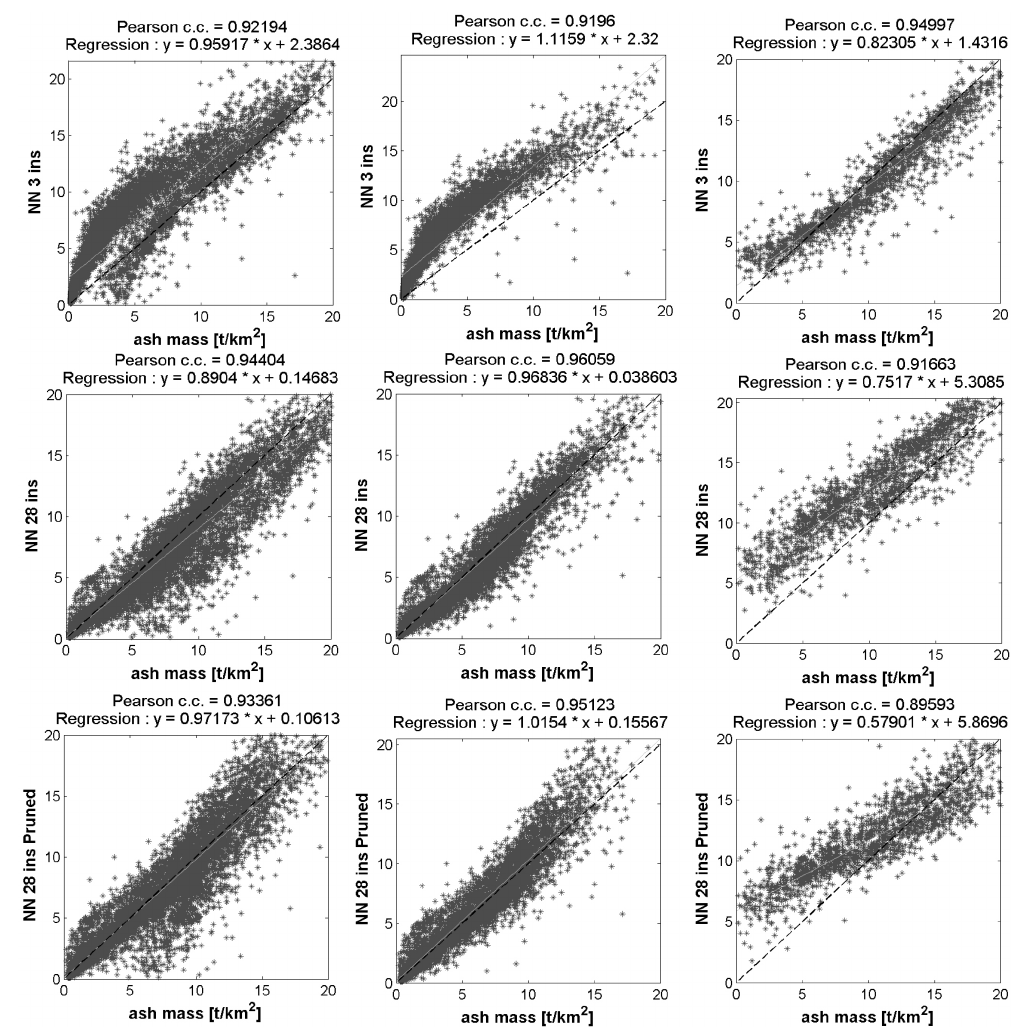
Figure 7. Scatterplots for ash mass networks, 3 inputs (top row), 28 inputs (middle row) and 28 inputs pruned (bottom) row, applied to the validation set of 16 May 2010, 12:30UTC, divided into total patterns (left column), patterns over sea (middle column) and patterns over meteorological clouds (right